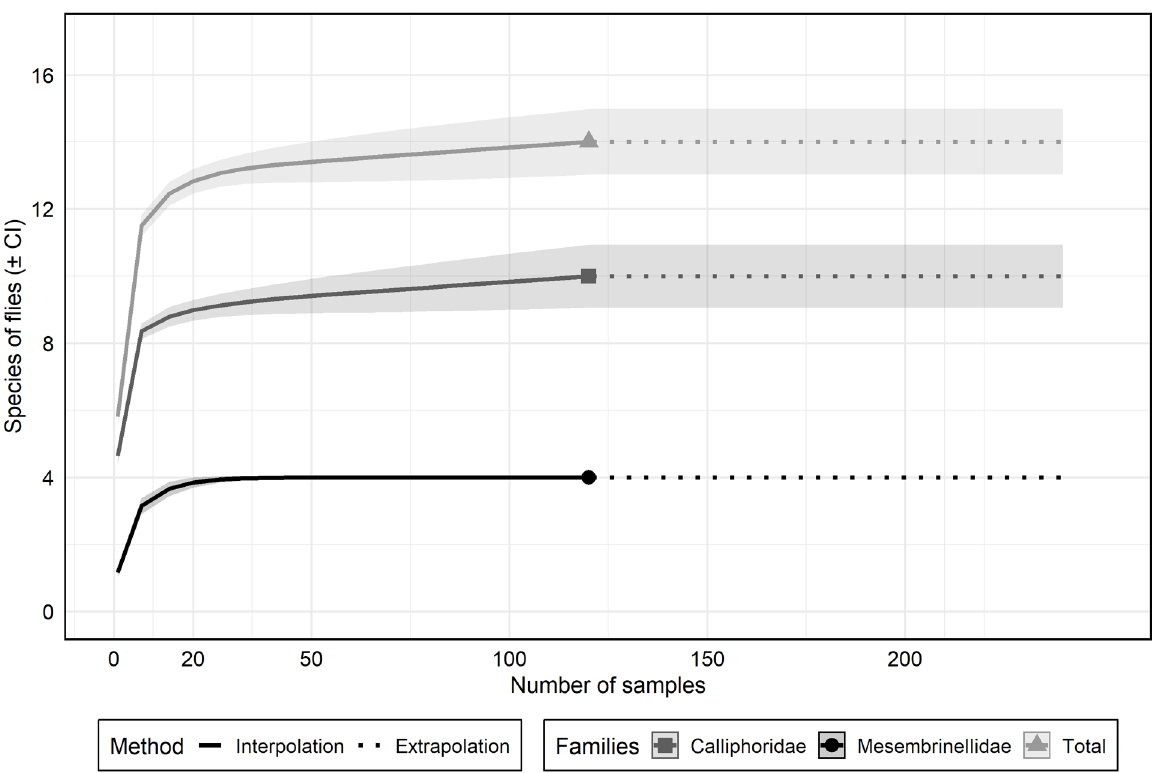
Figure 2. Species accumulation curve (based on rarefaction and extrapolation, CI = confidence interval) of total identified fly species (line with triangle), Calliphoridae species (line with square) and Mesembrinellidae species (line with circle) collected in Varzea Forest in Mazagão, Amapá State, Brazil. (The continuous line represents the observed species richness, and the dotted line represents the extrapolated richness of the samples; the polygons (square, circle, and triangle) represent the total number of samples in the study (120); and the thin lines above and below in a lighter tone represent the confidence interval of the